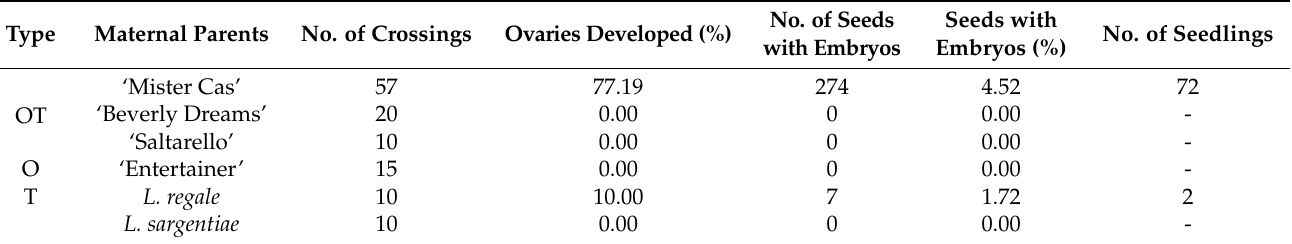
Table 7. Statistics of cross-pollination results with induced fertile